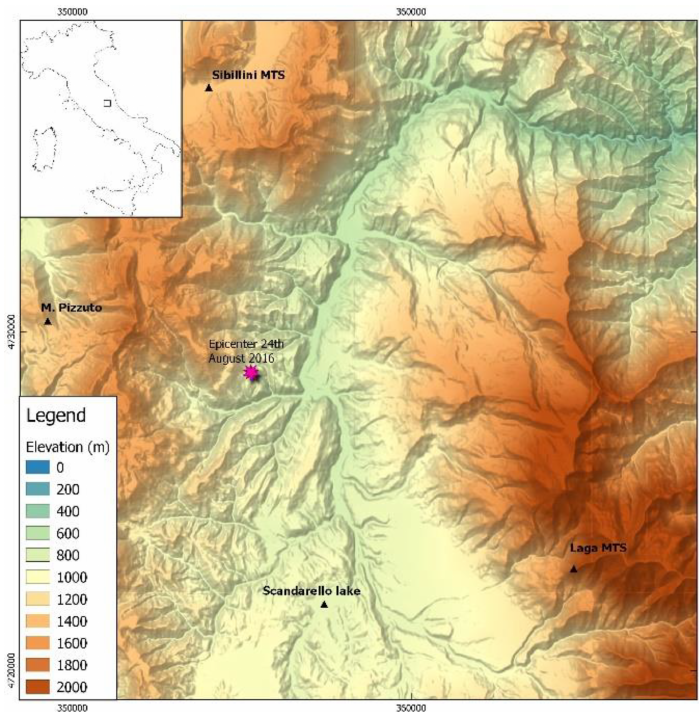
Figure A2. Elevation map for the area of Figs.